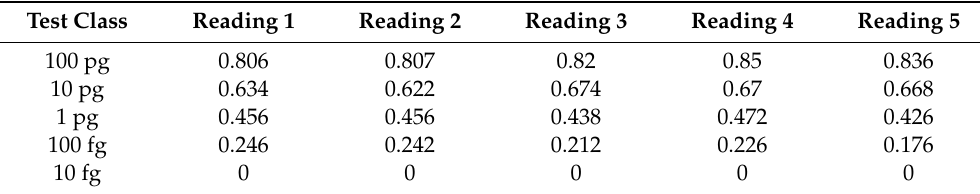
Table 2. Calculated T / C ratio for LFA set #2.